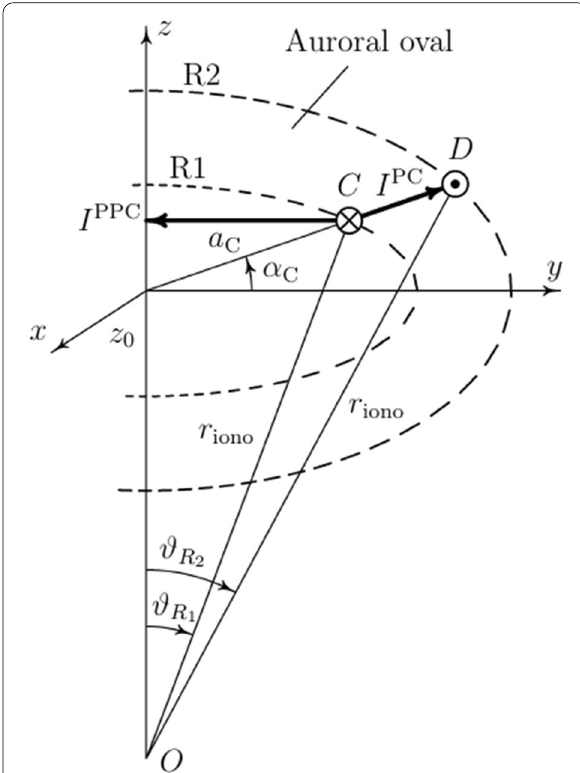
Fig. 19 The geometry considered to derive the magnetic field generated by a wire lying in the meridional plane ϕ = α C and carrying the Pedersen current I PC in the auroral oval along a circular arc between points C and D at Region 1 and Region 2, respectively. The arc has radius r iono and extends between the geocentric colatitudes ϑ R and ϑ R . The polar-cap Pedersen current I PPC flows 1 2 across the polar cap to the opposite local-time sector. Crossed and dotted circles represent the flow of FACs into and out of the ionosphere,